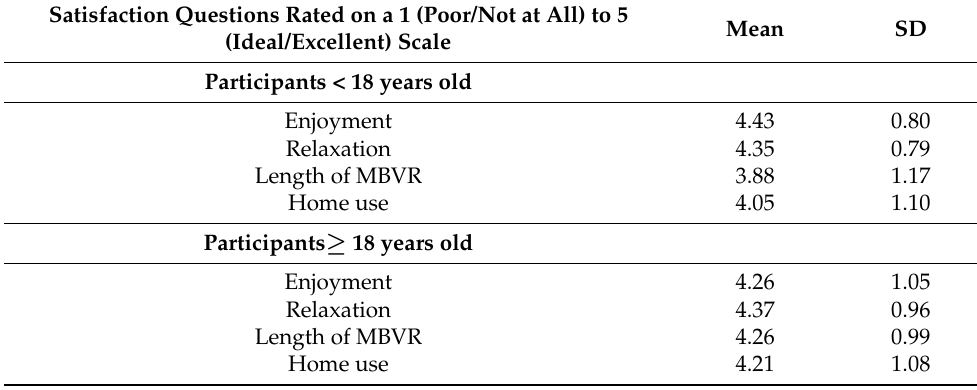
Table 2. Ratings of Feasibility and Acceptability by Age